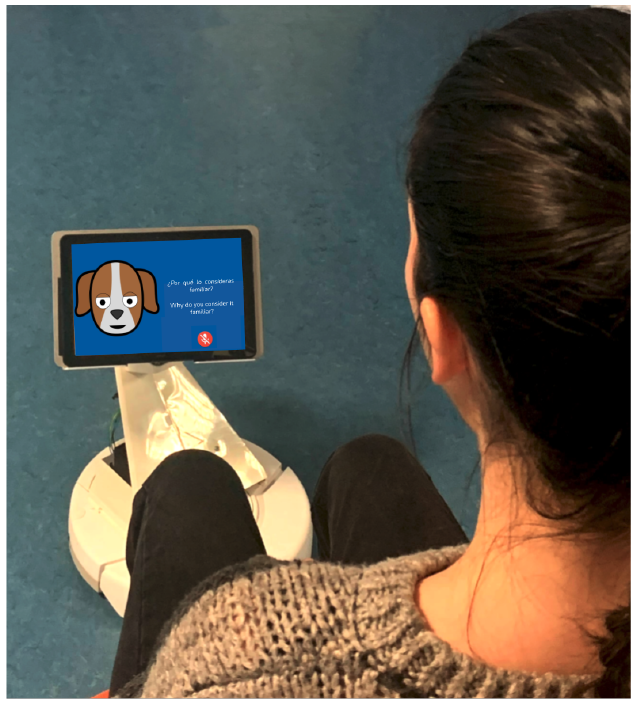
Figure 6. System appearance. The muted microphone under the text to the right of the avatar indicates the chatbot’s turn to